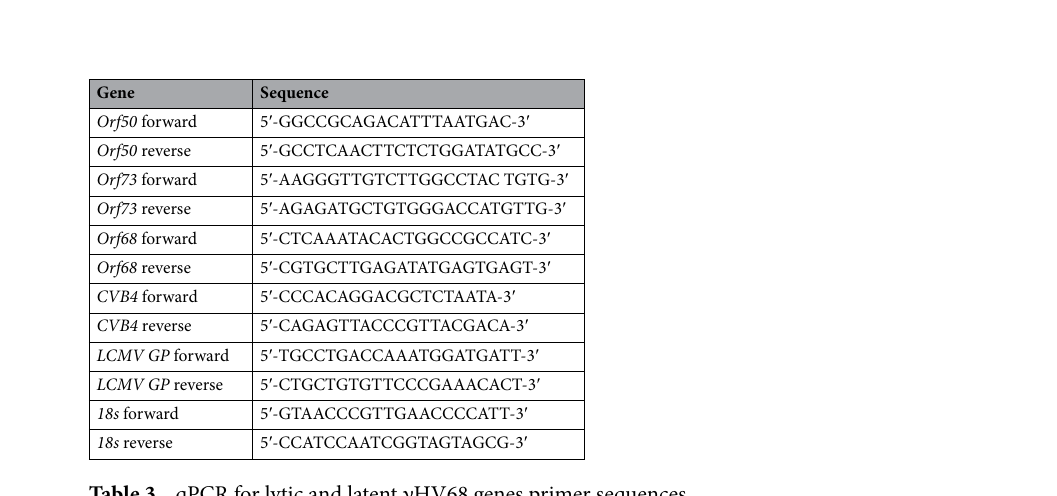
Table 3. qPCR for lytic and latent γHV68 genes primer